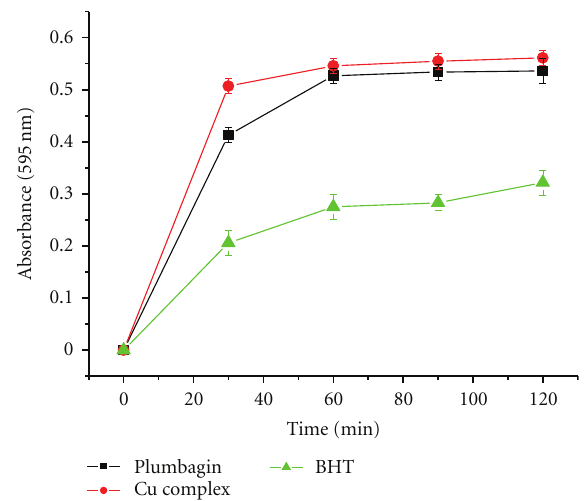
Figure 3: The total antioxidant power of plumbagin, Cu (II) com- plex, and BHT in di ff erent reaction times (20, 40, 60, 80, 100, and 120min).